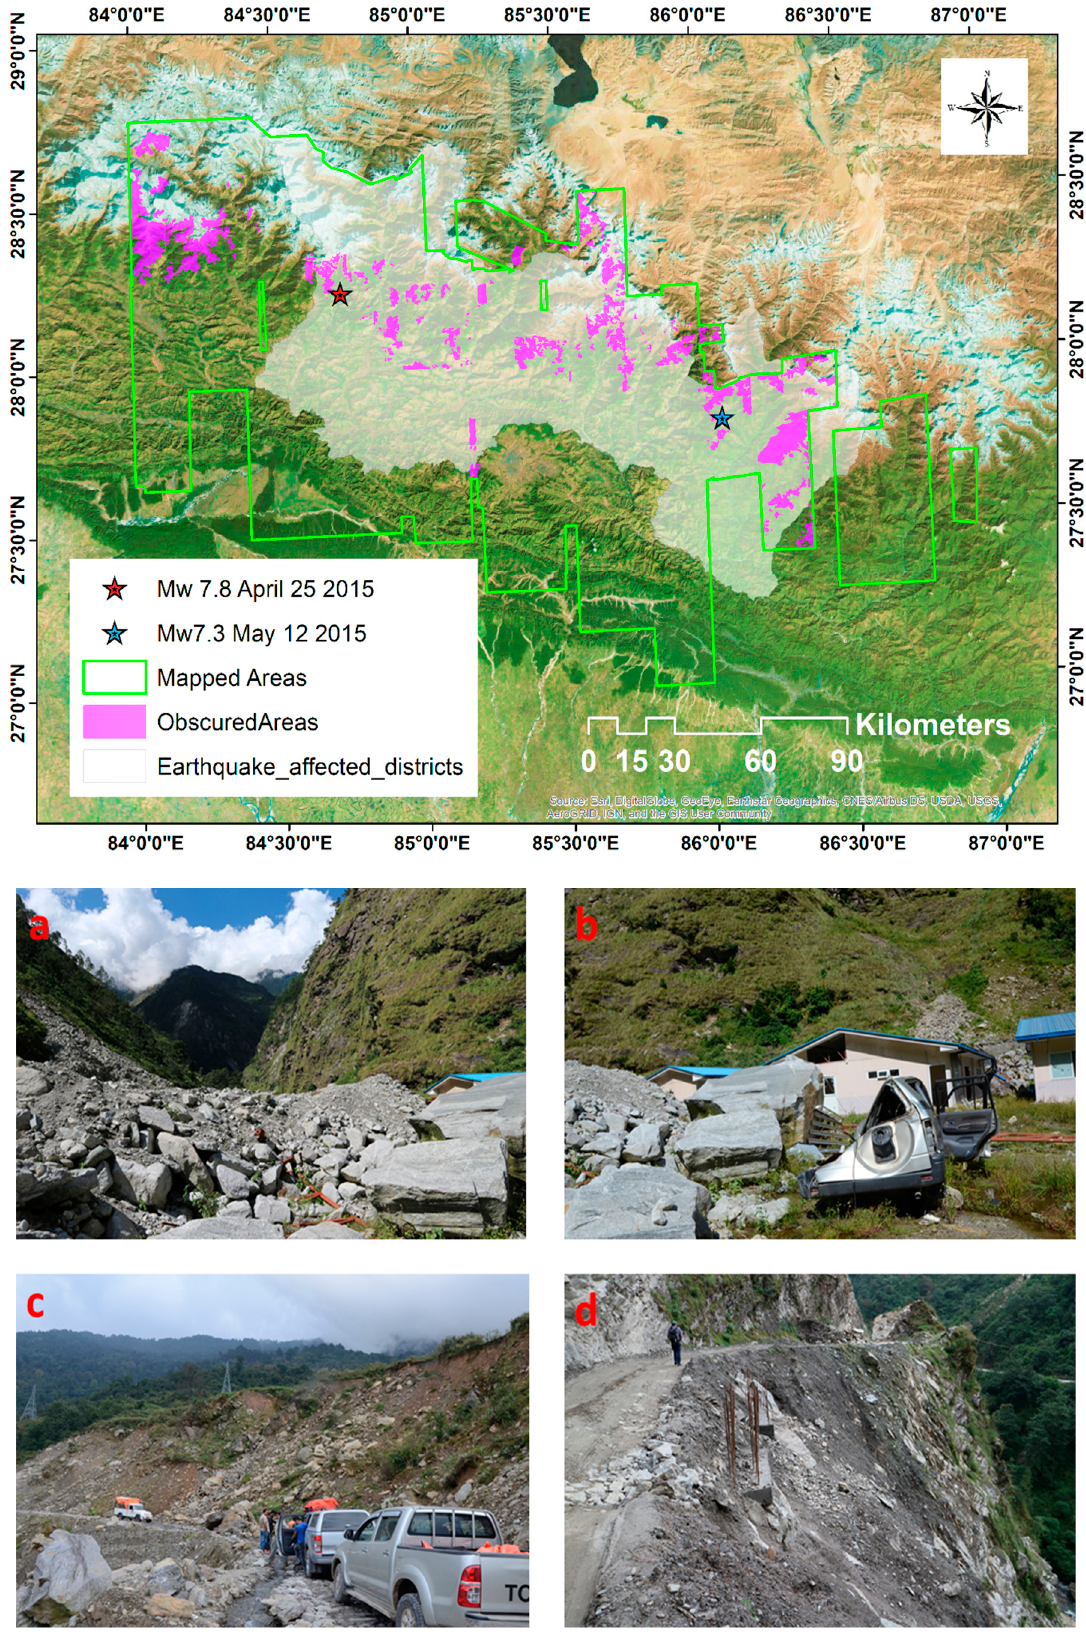
Figure 1. Map showing the location of the study area and field photographs: ( a ) Mailung Khola and ( b ) camp near Mailung Khola hydropower plant ( c ) road section near Ramche ( d ) road section near Syaprubesi.